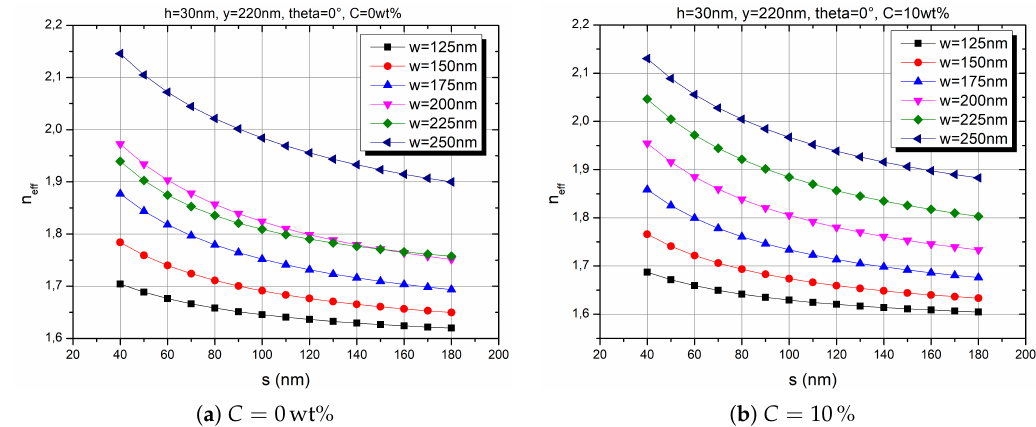
Figure A3. Effective refractive index n eff for both concentrations as a function of s and with w as parameter.